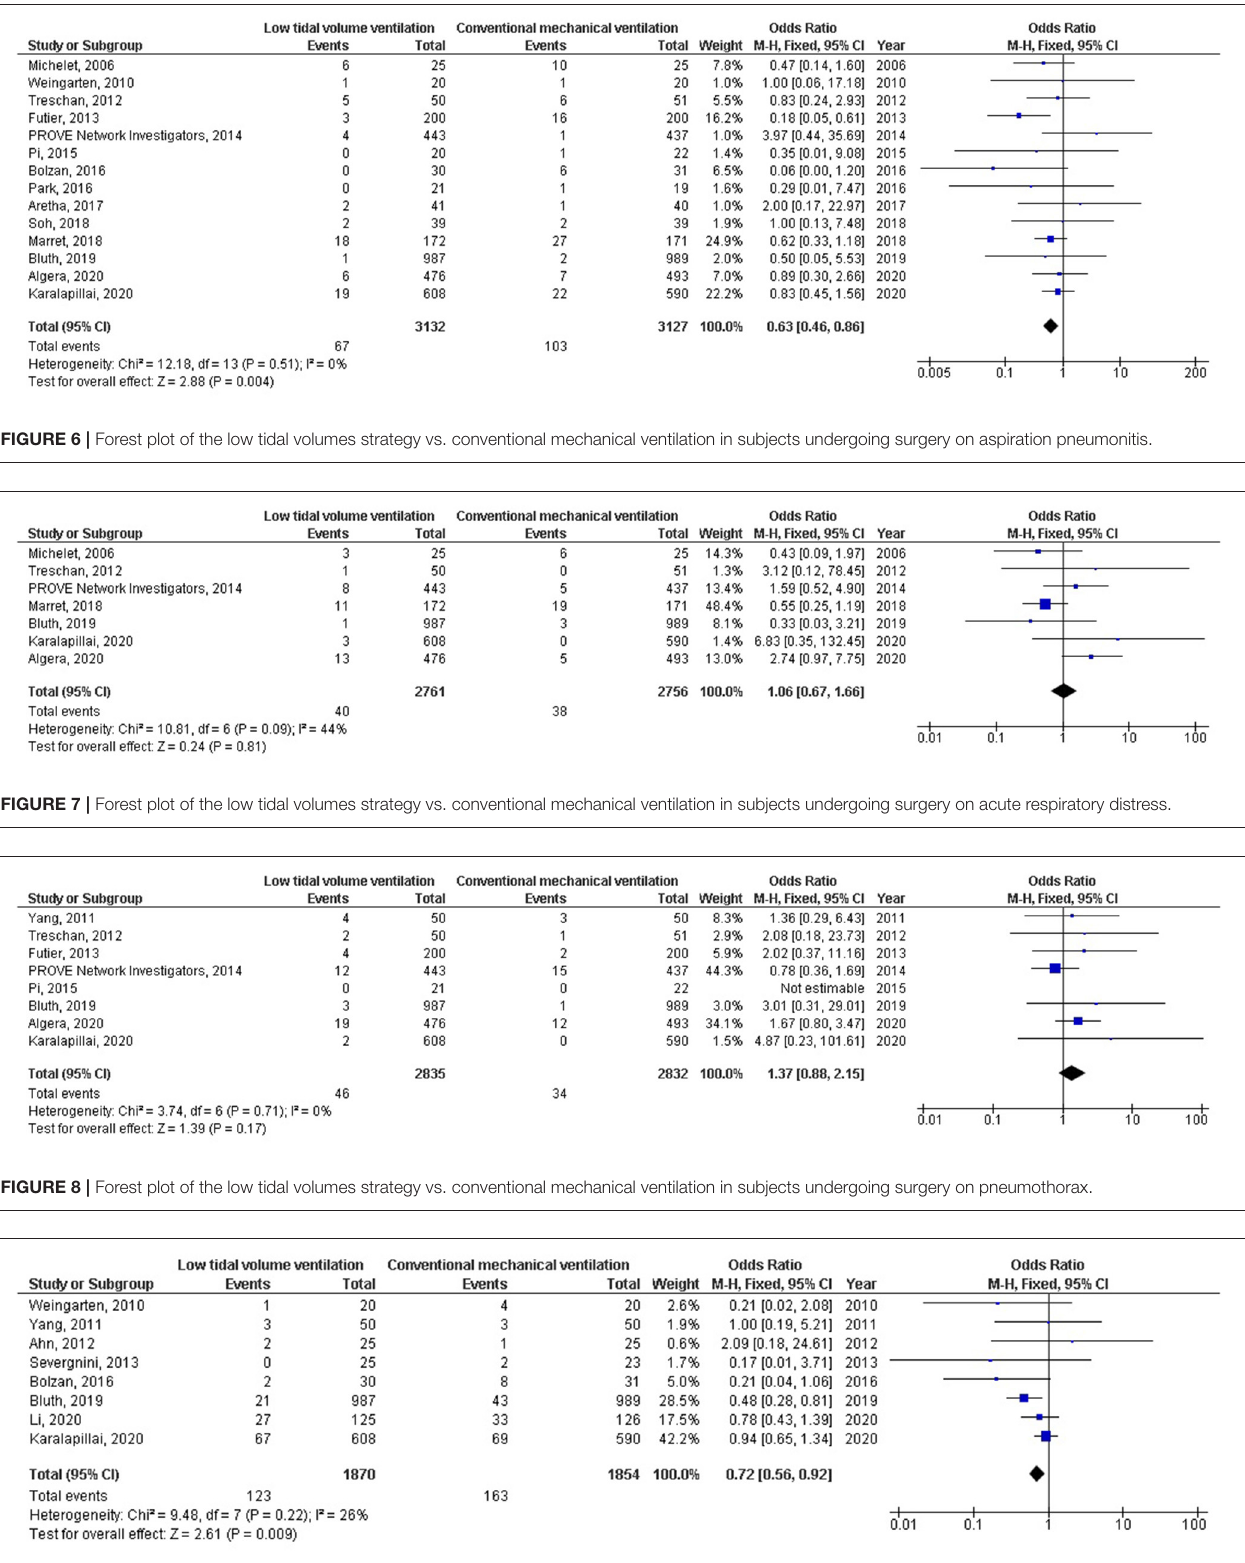
Frontiers in Surgery |